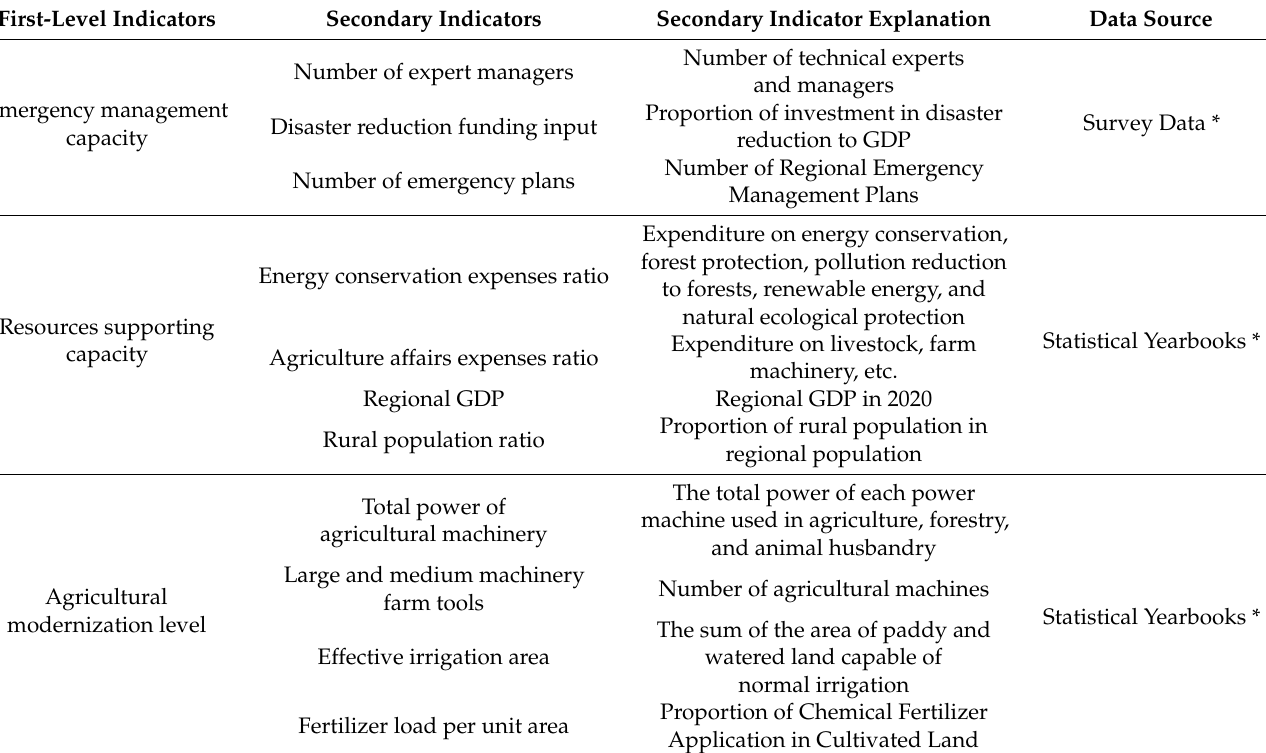
Table 2. Regional agricultural drought mitigation capacity indicator